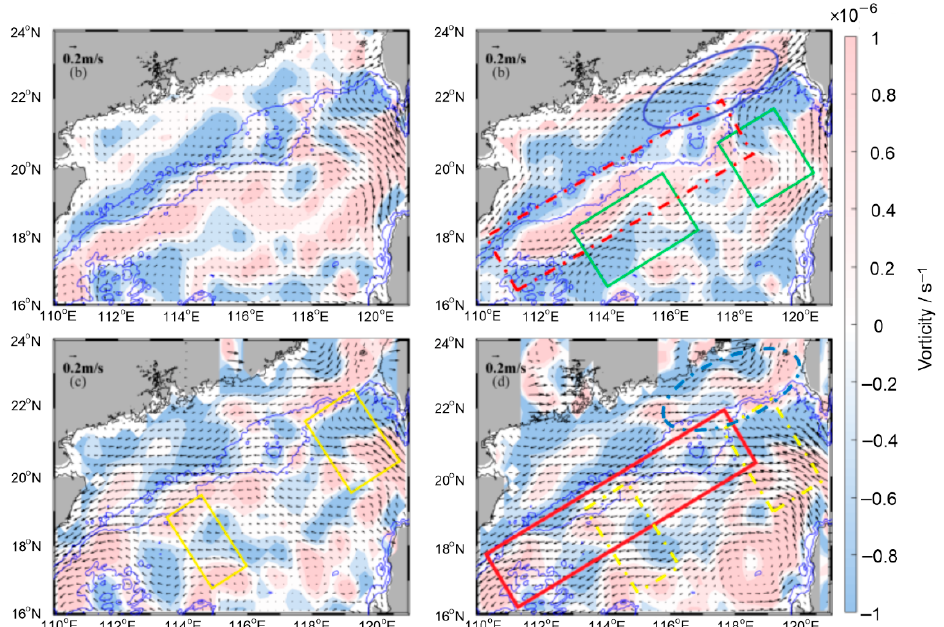
Figure 12. The average seasonal variability of the background flow field (arrows) and the vorticity field (colored) in the northern SCS derived from the CMEMS current velocities data during: ( a ) spring, ( b ) summer, ( c ) autumn, ( d ) winter. The red, yellow, green, and blue frames represent cluster areas for the along-the-isobath type, the intrusion-of-continental-shelf type, the local wandering type, and the shelf-internal-generation type, respectively. The solid and dotted boxes represent the cluster area for the largest and the smallest number of eddies, respectively.